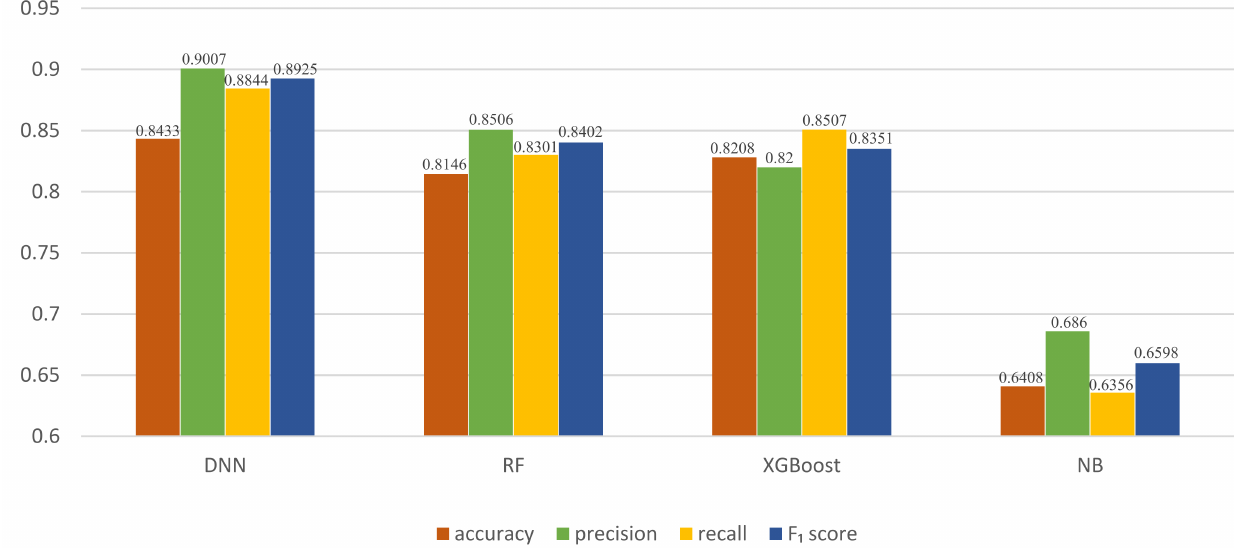
Figure 6. Performance of the different classification strategies.